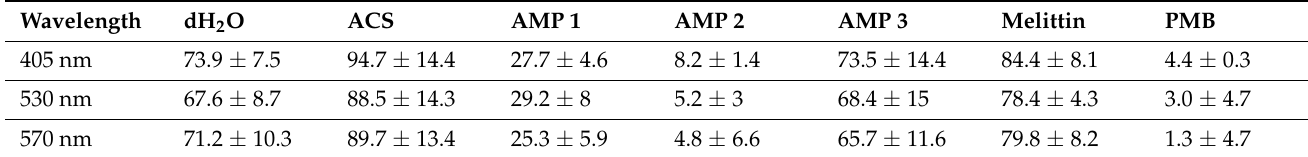
Figure 7. OD measurements of free hemoglobin in 1% washed human erythrocytes at 405 nm ( A ), 530 nm ( B ), or 570 nm ( C ). Samples were treated with PBS (negative control), AMPs 1, 2, 3, melittin or polymyxin B (all at 100 µ M), as well as with dH 2 O, ACS, or different concentrations of Triton X-100, Tween, or SDS. All samples were incubated for 60 min at 37 ◦ C. Average values from three experimental replicates, each containing two technical replicates, are presented with error bars (SD) included in plots. Table 6. Calculated hemolysis ratios according to Equation (1) for AMPs 1, 2, and 3, melittin and polymyxin B (PMB) (all at 100 µ M), as well as for dH 2 O and ACS from measurements at 405, 530, and 570 nm on 1% washed human erythrocytes. Measurements from samples with 10% Triton X-100 (positive control) and PBS (negative control) were used as 100% and 0% hemolysis for the normalization. Normalization was performed on data averaged from three experimental replicates, each containing two technical replicates.